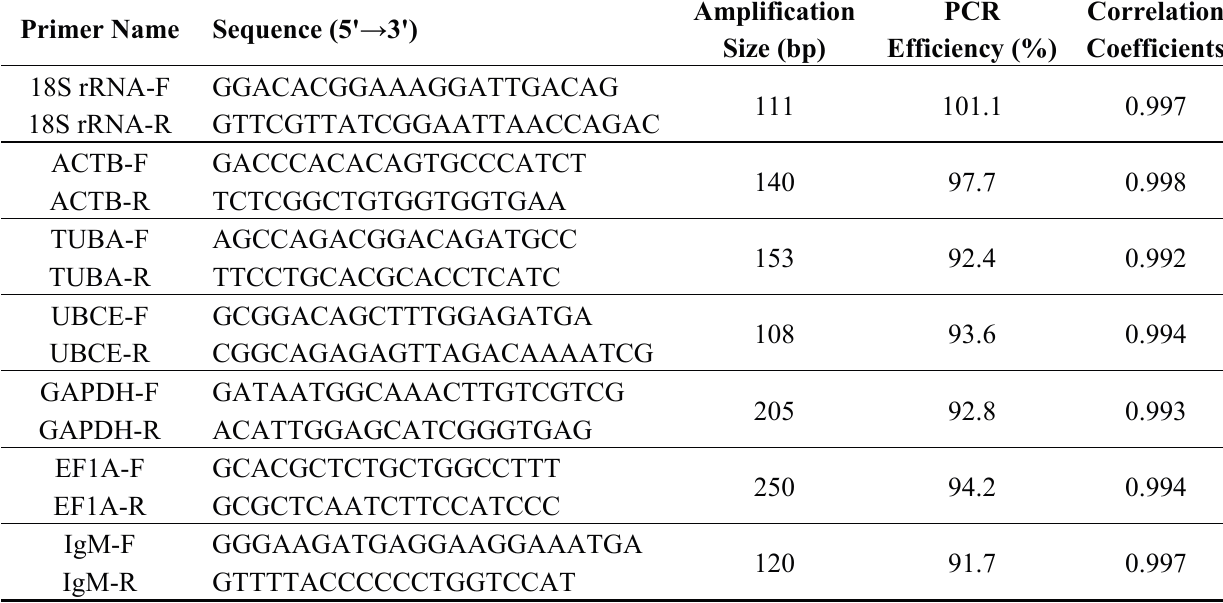
Table 1. Primer sequences and PCR